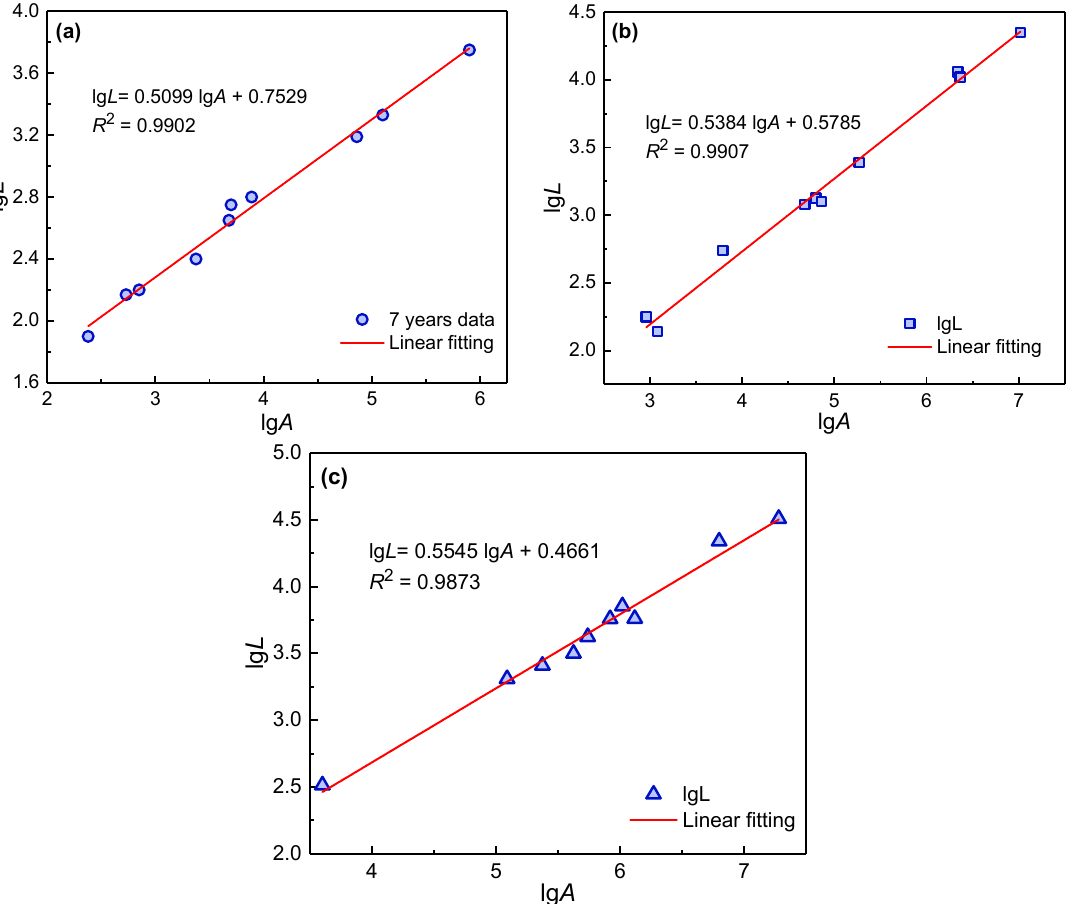
Figure 10. The relationship between the logarithmic perimeter (lg L ) and the logarithmic area (lg A ) of the regions of surface corrosion of specimens exposed for different durations, and the results of linear fitting: ( a ) 7 years; ( b ) 12 years; ( c ) 20 years.